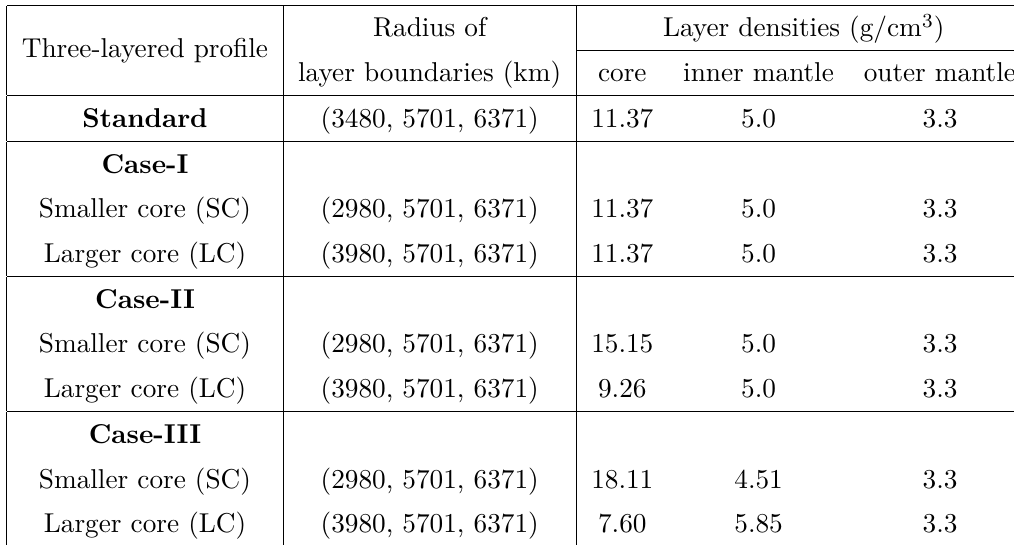
Table 1 . Boundaries of three layers and their densities in the three-layered profile of Earth when R CMB is modified by ∆ R CMB . Smaller core (SC) stands for ∆ R CMB = − 500 km, while larger core (LC) represents ∆ R = +500 km. The corresponding modifications of density profiles are given CMB by the cases I, II, III (see section